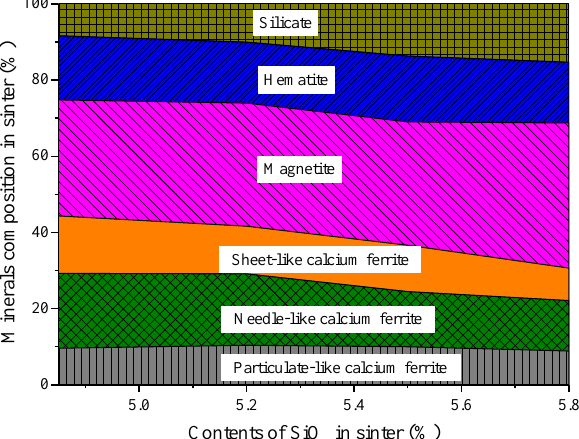
ff ects of SiO Figure 8. Effects of SiO 2 content on mineral composition. Figure 8. E 2 content on mineral Figure 8. Effects of SiO 2 content on mineral composition.